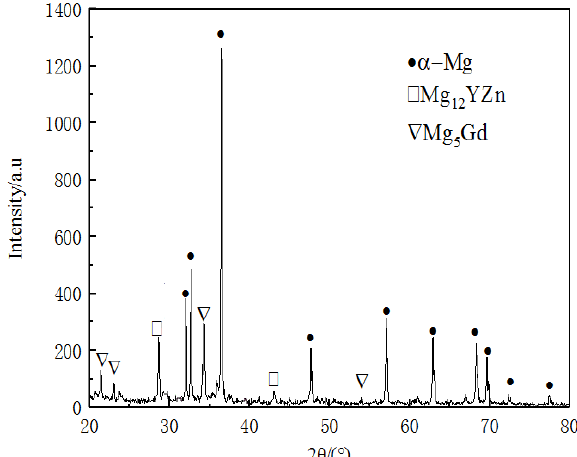
Figure 7. X-ray Diffraction (XRD) results for alloy subjected to 230 °C × 20 h ageing treatment.